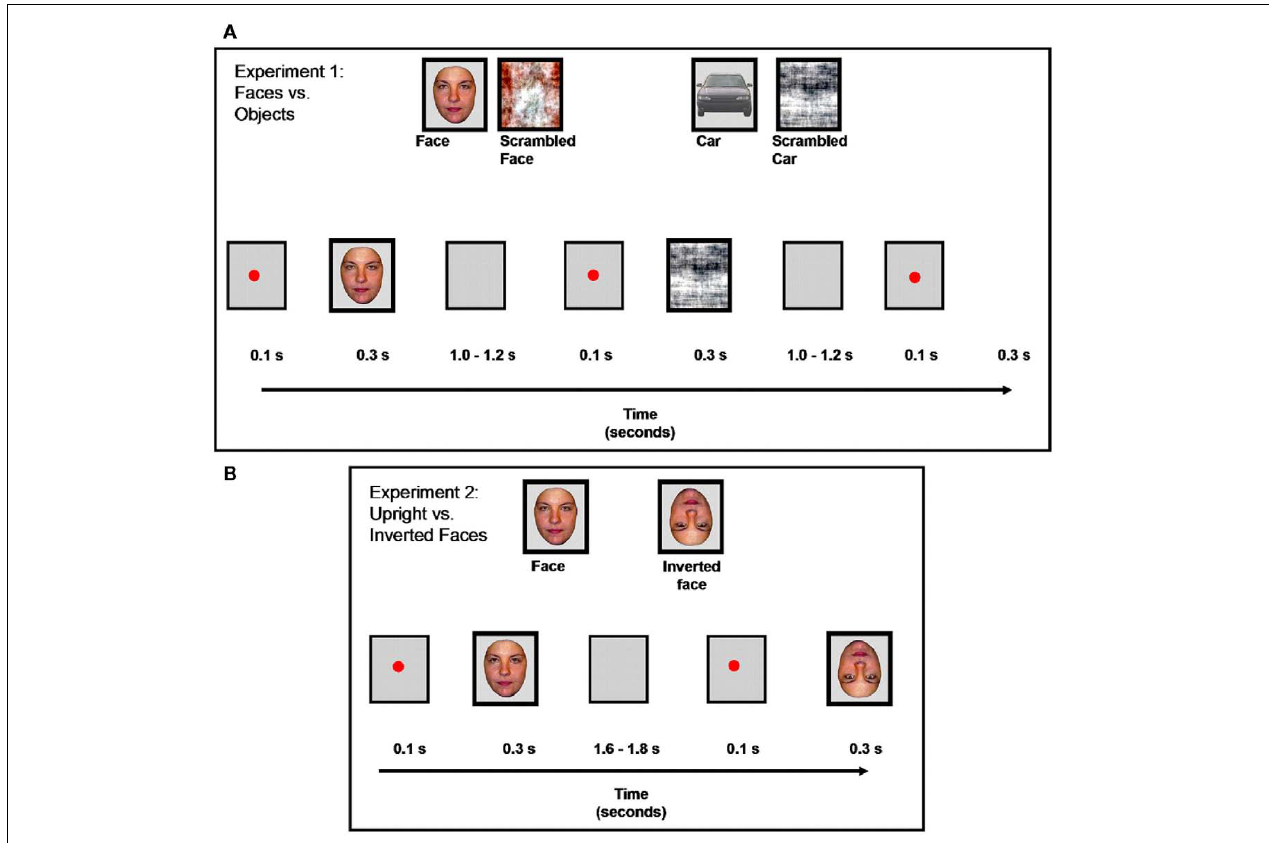
FIGURE 2 | Examples of stimuli and experimental design for the two experiments. (A) : Experiment 1, faces vs . objects. (B) : Experiment 2, upright vs . inverted faces.